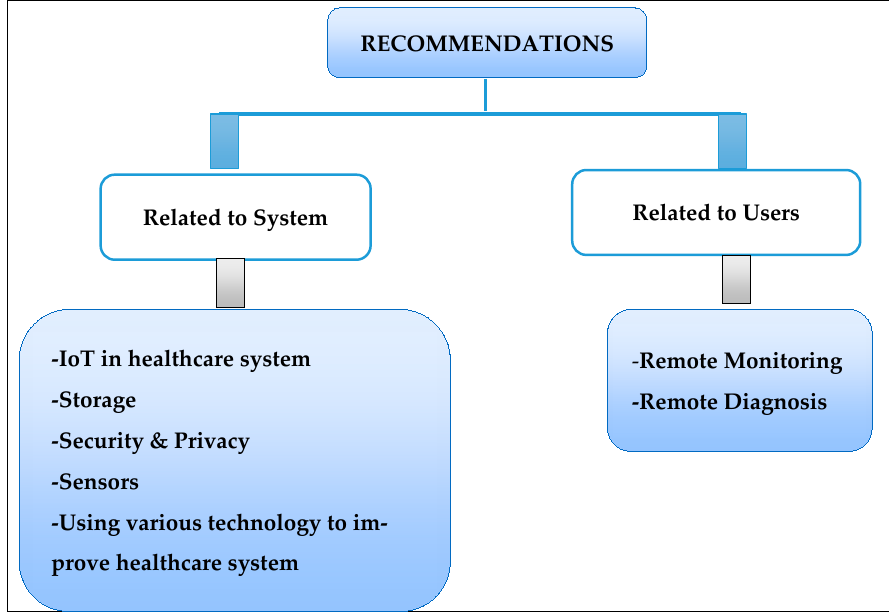
Figure 14. A summary of the recommendations from studies on enabling IoT in the healthcare system and service delivery.